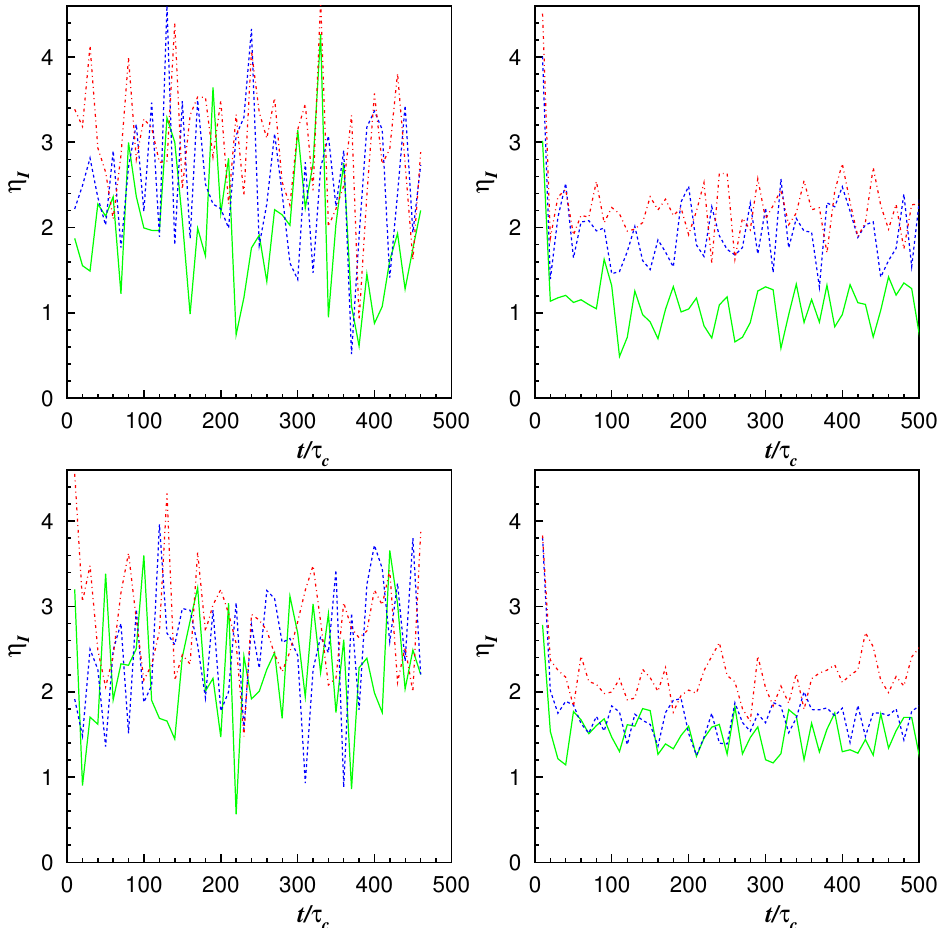
Figure 1. Time behavior of the intrinsic viscosity η I (values are averaged over time intervals of duration ∼ 10 τ c to smooth out noise) at S ∗ = 0.80 (upper row) and S ∗ = 0.95 (lower row) for κ / ( k B TR 0 ) = 6.58 ( left ), 65.8 ( right ) with λ = 1 (full green line), 7 (dashed blue line), 15 (dot-dashed red